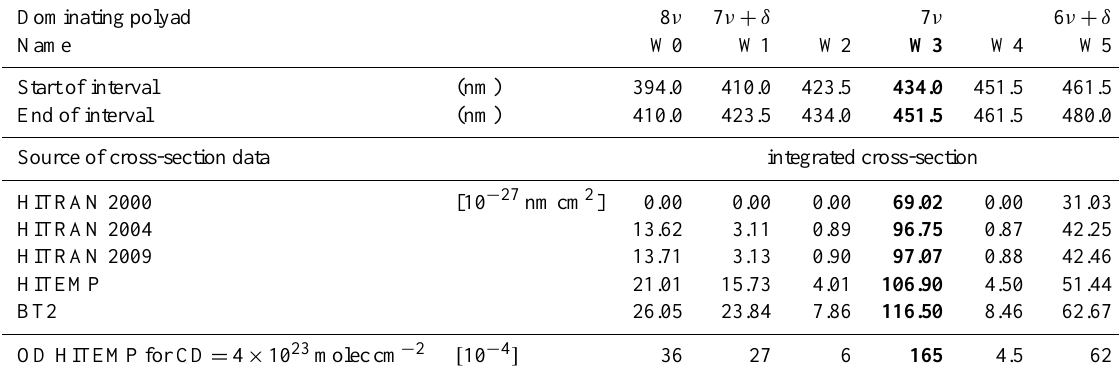
Table 3. Integrated absorption in [10 − 27 nmcm 2 ] over each of the wavelength intervals W0–W5 for different sources of cross-section data. Not only are W3 variations (reference measurements, bold face) between the different compilations seen for the largest absorption structure but relative integrated absorption values also vary. The last row shows the maximum optical density for a water vapour column density (CD) S = 4 × 10 23 moleccm − 2 within each wavelength interval at a spectral resolution of